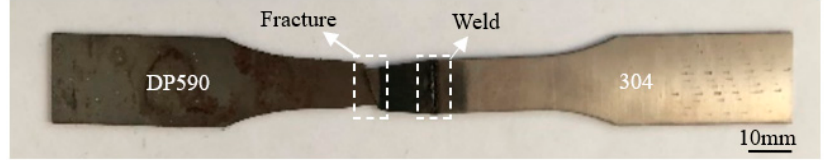
Figure 13. Tensile fracture Sample 4 with the fracture being on the DP590